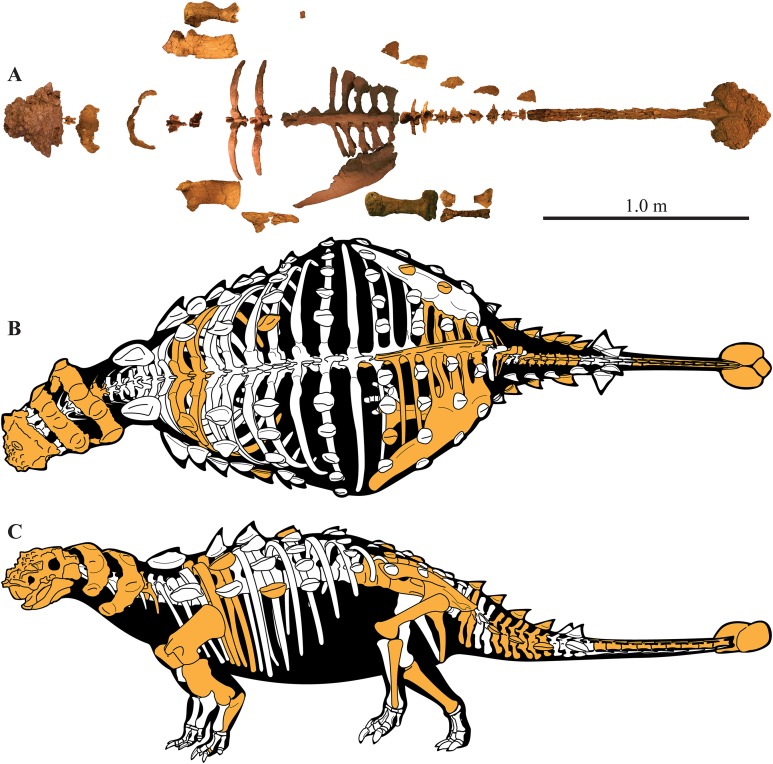
Preserved elements and skeletal reconstructions of Akainacephalus johnsoni.A composite showing all holotype skeletal material of Akainacephalus johnsoni (UMNH VP 20202) anatomically arranged in dorsal view (A). Cartoon illustrating a full body reconstruction for A. johnsoni in (B), dorsal; and (C), left lateral view. Preserved material in the skeletal reconstructions is highlighted in orange.